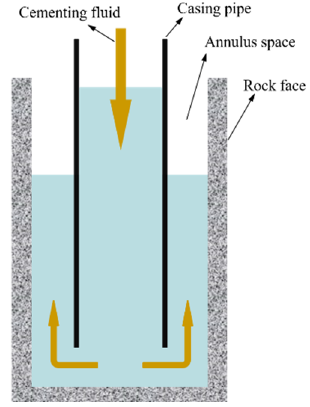
Figure 1. Schematic of cementing fluid flows in the annulus space.